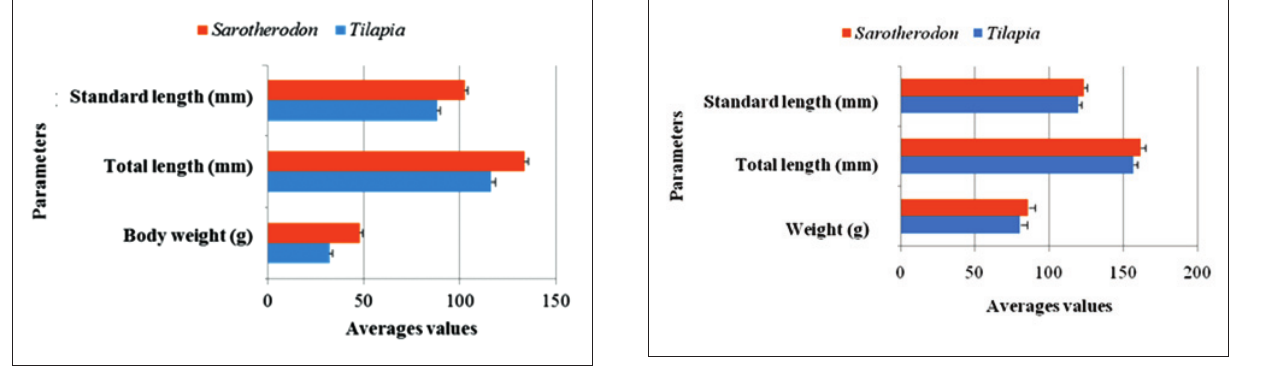
Figure-3: Morphometric parameters of Tilapia guineensis and Sarotherodon melanotheron in NokouéLake